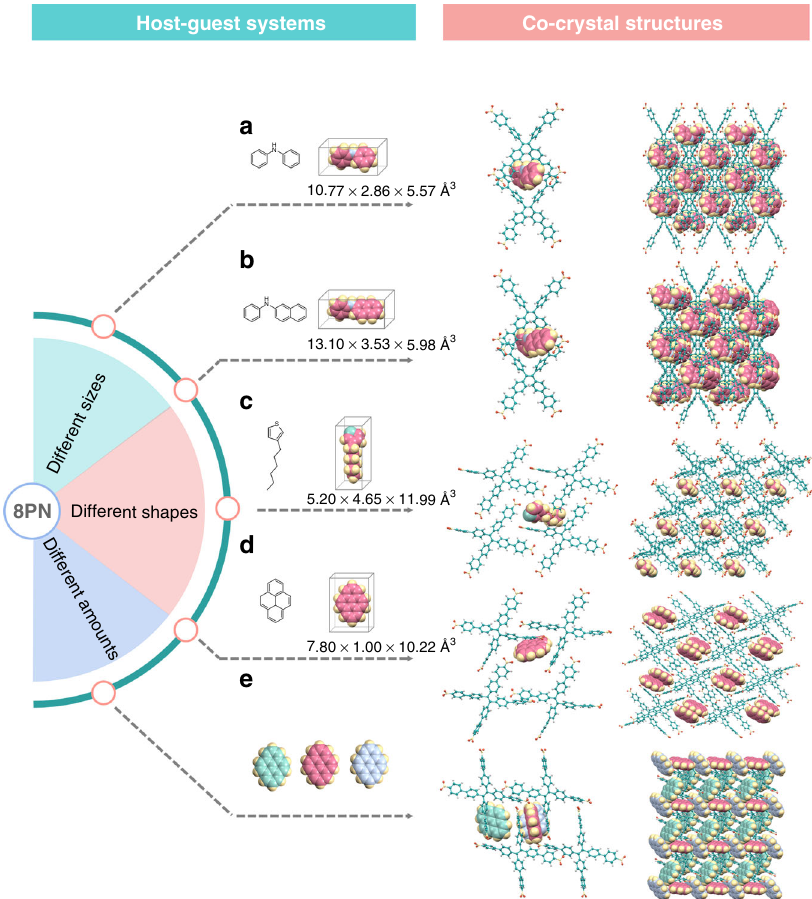
Fig. 5 Summary of the adaptive accommodations of different guests by 8PN in various host − guest co-crystal structures. a Molecular size of diphenylamine and single-crystal X-ray structure of 8PN-NDP. b Molecular size of N -phenylnaphthalen-2-amine and single-crystal X-ray structure of 8PN-NPNA. c Molecular size of 3-hexylthiophene and single-crystal X-ray structure of 8PN-SC6. d Molecular size of pyrene and single-crystal X-ray structure of 8PN-PY. e single-crystal X-ray structure of 8PN-3PY. Color code for TPE-4pn: green, C; yellow, N; orange, O; gray, H. Color code for guests: pink, C; yellow, H; blue, N; light green, S, except that C atoms of the three pyrene molecules in the unit cell of 8PN-3PY are colored pink, light green, and light blue, respectively,